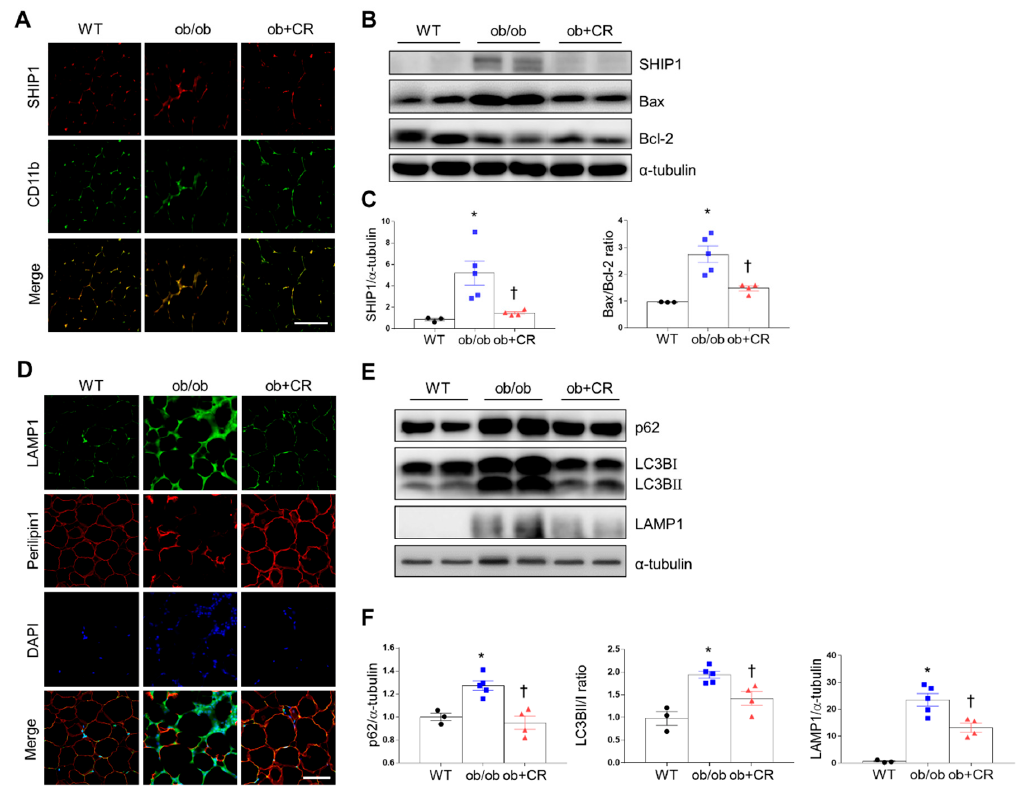
Figure 6. E ff ects of caloric restriction (CR) on SHIP1 expression in the adipose tissue of ob / ob mice. ( A ) Representative immunofluorescent images (200 × ) of SHIP1 (red) and CD11b (green) in the adipose tissue of control (CTL) mice relative to ob / ob mice or ob + CR mice. ( B ) Western blot analysis of SHIP1, Bax, and Bcl-2 protein expression, using α -tubulin as a reference protein. ( C ) Quantitative Western blot analysis of SHIP1 and Bax / Bcl-2 ratio in adipose tissue. ( D ) Representative immunofluorescent images (200×) of LAMP1 (green) and perilipin 1 (red) in the adipose tissue of CTL mice relative to ob/ob mice or ob + CR mice. ( E ) Western blot analysis of p62, LC3B, and LAMP1 protein expression, using α -tubulin as a reference protein. ( F ) Quantitative Western blot analysis of p62, LC3B Ⅱ / Ⅰ ratio, and LAMP1 in adipose tissue. Data are presented as the means ± SEM; * p < 0.05 versus CTL mice; † p < 0.05 versus ob/ob mice. Scale bar = 50 μ m. WT, wild type. CTL (black circle), ob/ob (blue square), ob/ob+CR (red triangle).